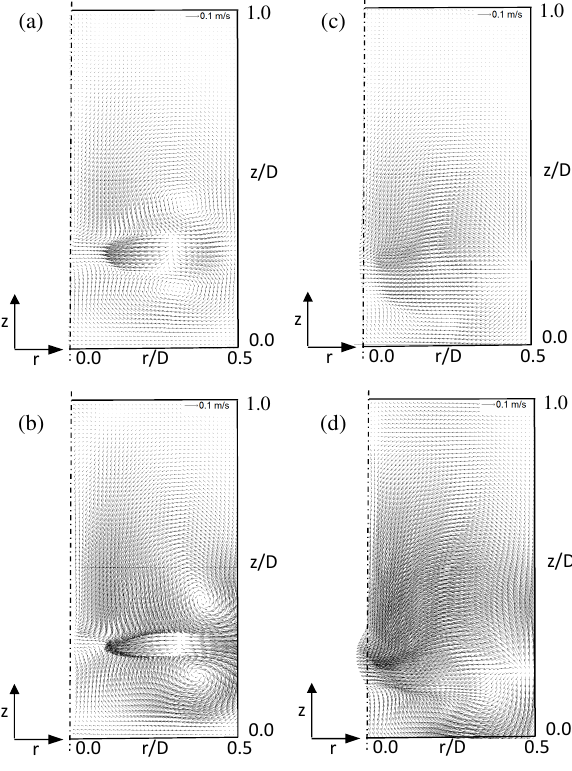
Fig. 9. Mean velocity field for h/H =1/2 and Rushton turbine (a,b), novel impeller (c,d) and rotational speed N =100 rpm (top), N =300 rpm